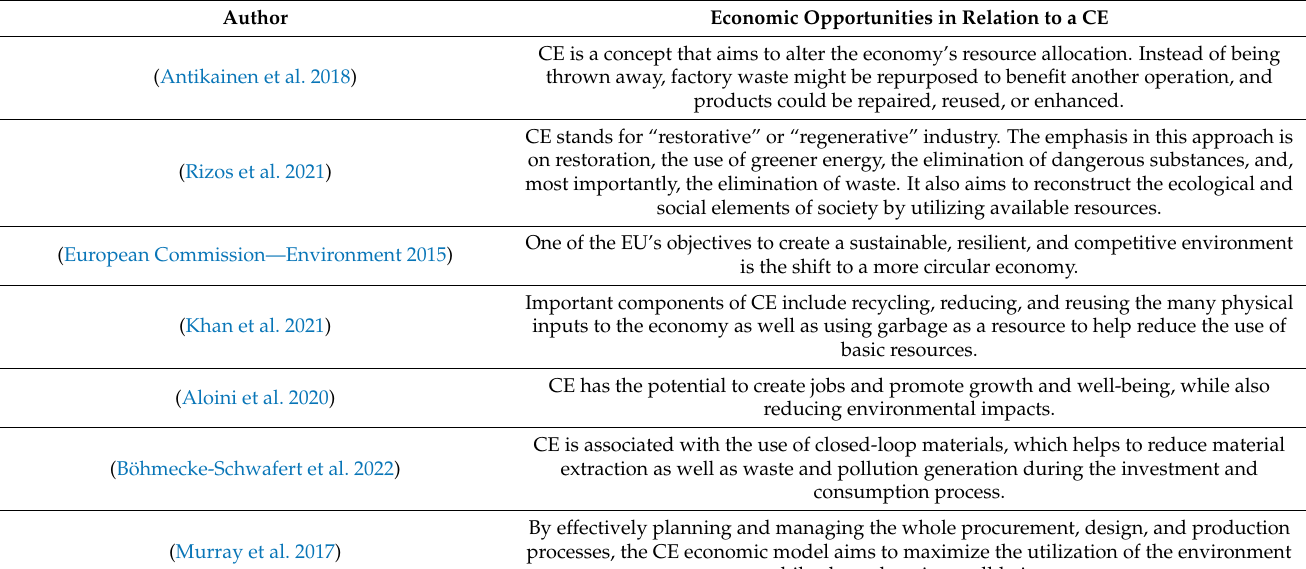
Table 1. Economic opportunities of a